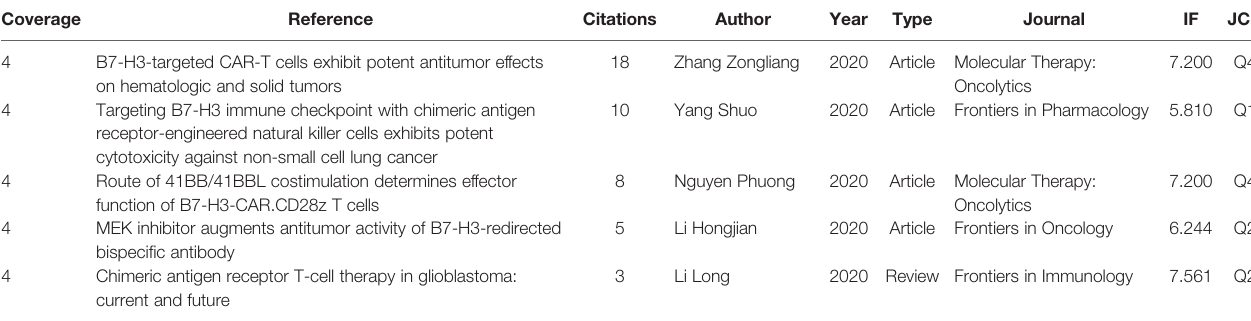
TABLE 7 | Top 5 citing References in cluster #15 of the overlay analysis of co-cited references and keywords.